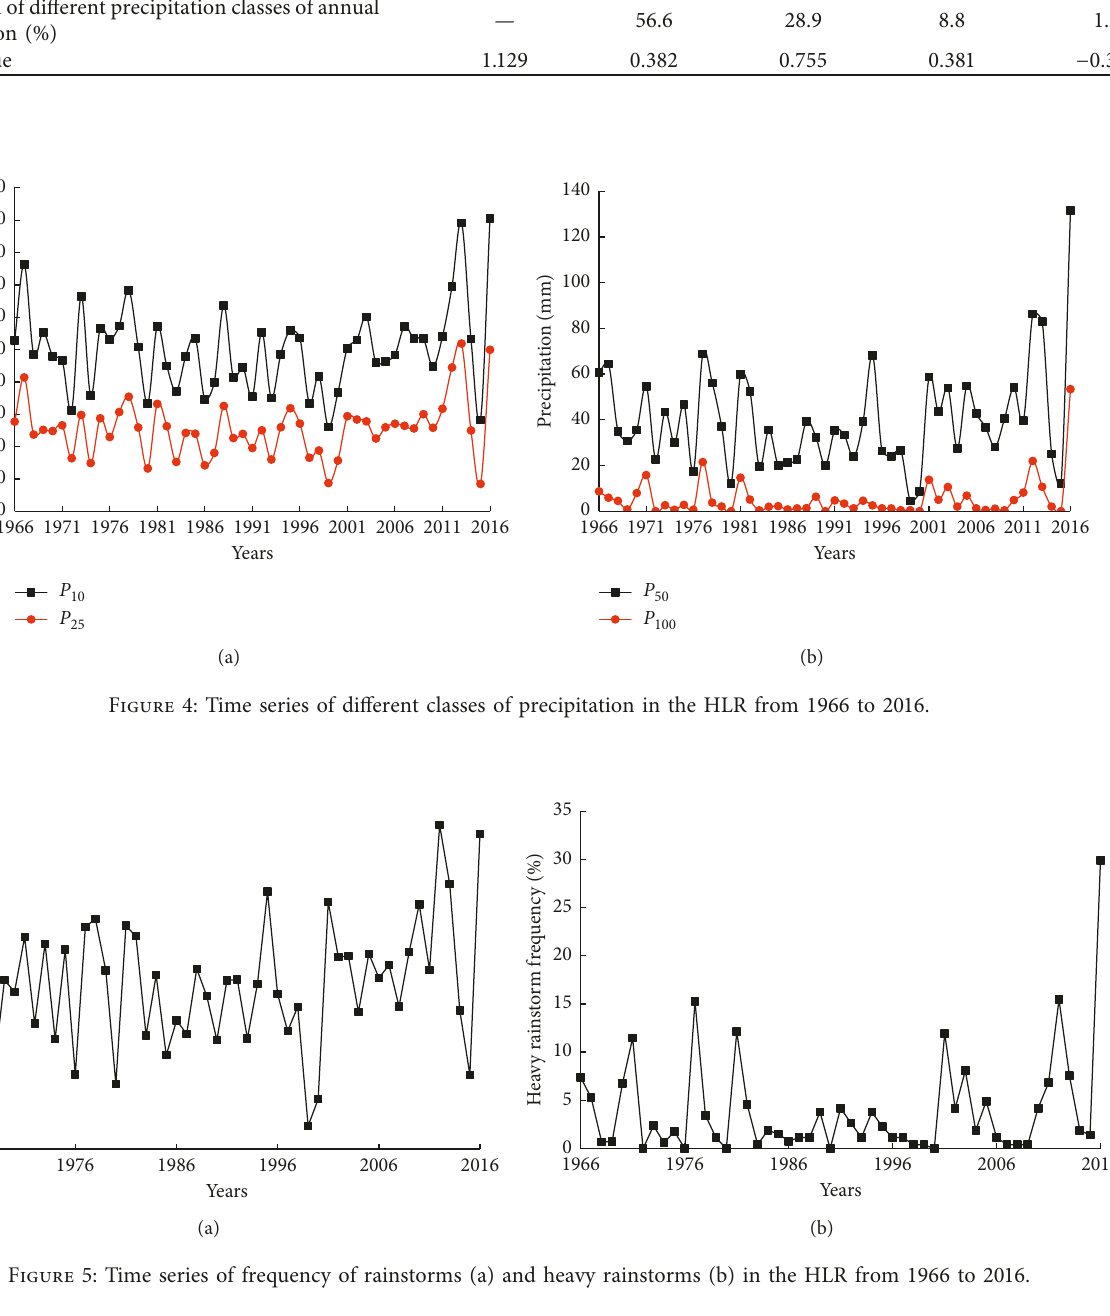
Table 2: The frequency and rainfall proportion of rainstorms and heavy rainstorms during different periods in the HLR (%). Rainstorm Heavy rainstorm Period Average annual frequency Rainfall proportion Average annual frequency Rainfall proportion